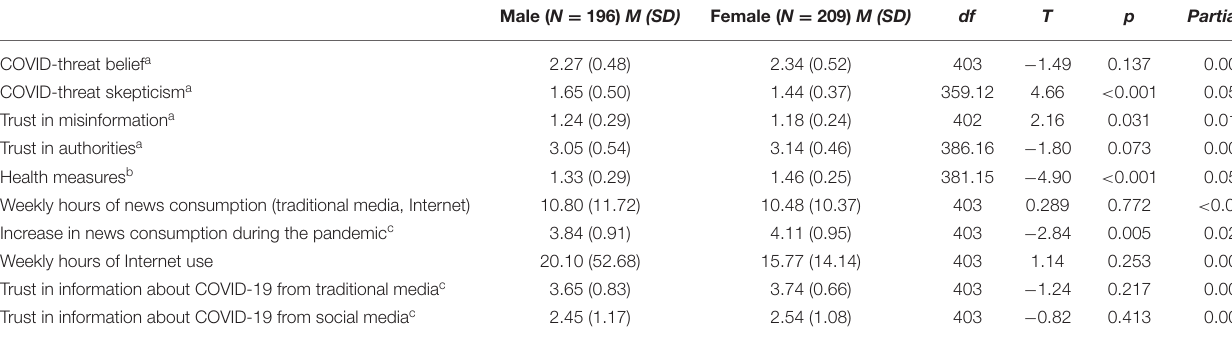
TABLE 1 | Gender comparison of attitudes toward COVID-19 and use of and trust in media (Independent samples t